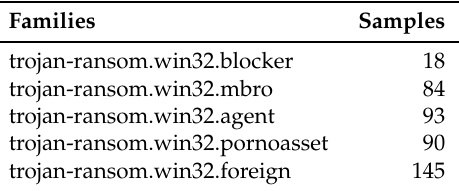
Table 7. Ransomware families of Domain 2 dataset.